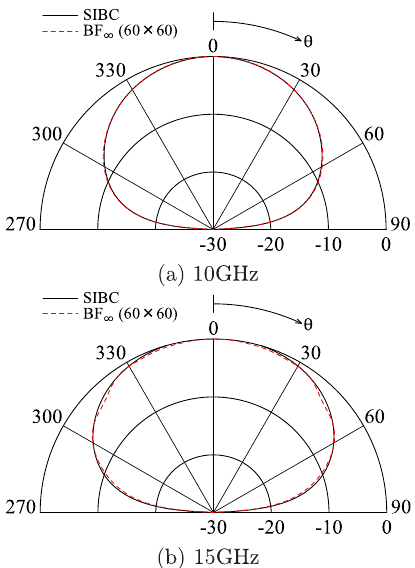
Fig. 12. Radiation patterns of half-wavelength dipole antenna in z – x plane ( h = l /10) .